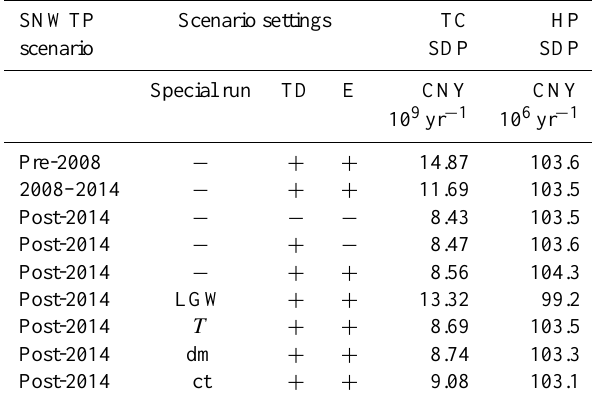
Table 3. Average minimum total cost (TC) and hydropower benefits (HP) over the 51-year planning period for different scenario